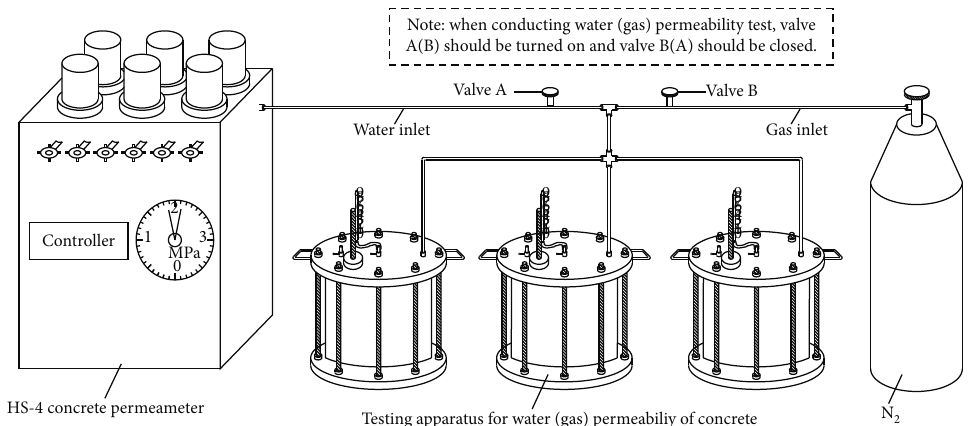
Figure 2: Schematic diagram of device for measuring permeability of concrete.